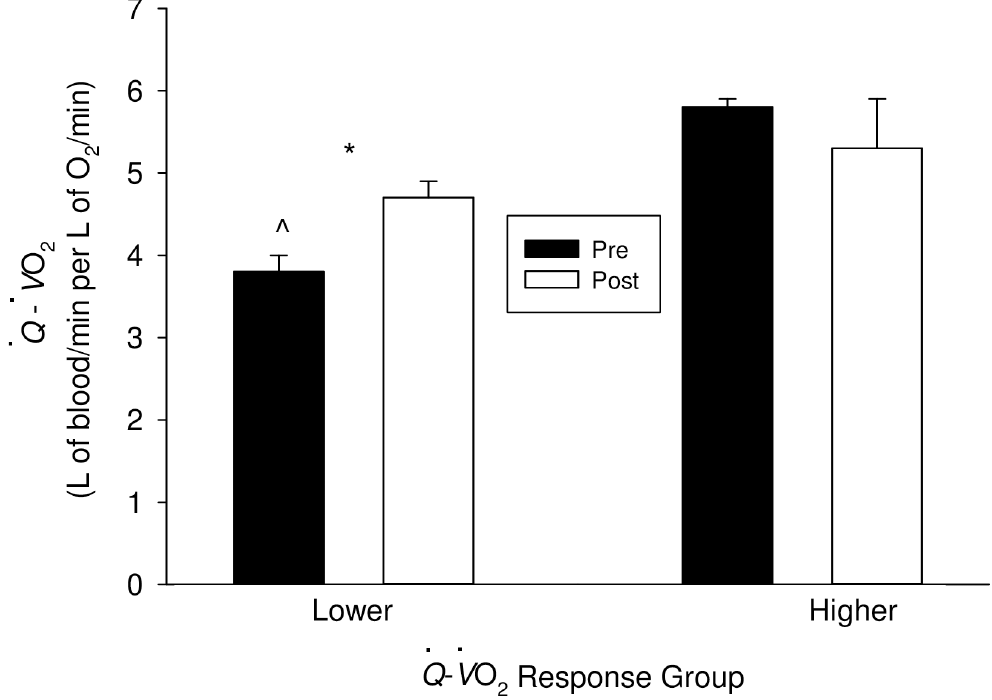
Fig 2. Exercise training and _ Q - _ V O . ^ denotes statistically significant difference between lower and higher cardiac 2 response groups within a time period (P < 0.05). � denotes statistically significant difference between pre and post-training within a cardiac response group (P <